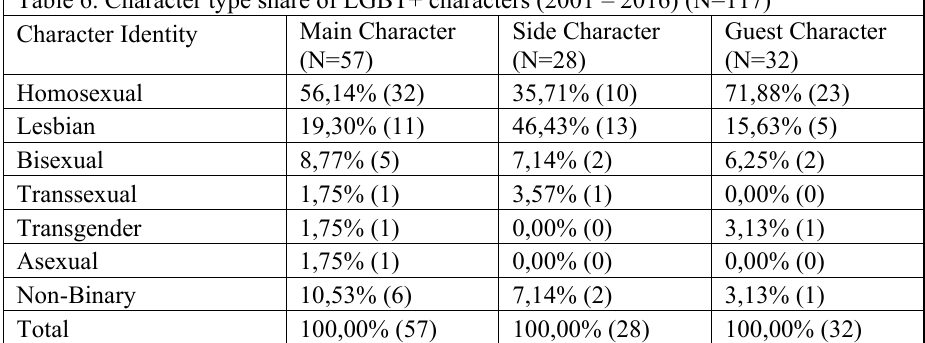
Table 6. Character type share of LGBT+ characters (2001 – 2016)